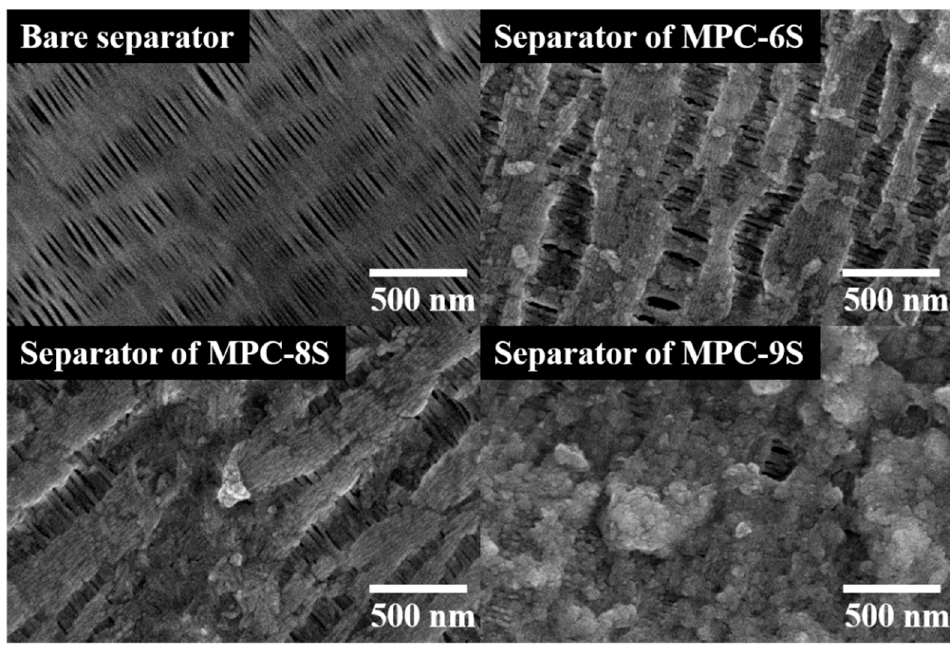
Figure 7. Surface images of the bare separator and separators of MPC-6S, MPC-8S, and MPC-9S after 100 cycles.